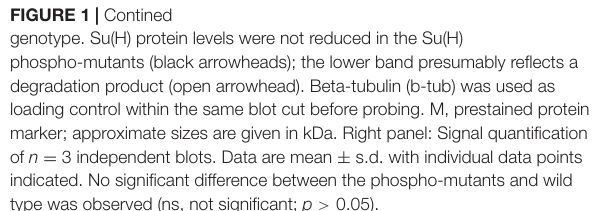
FIGURE 1 | Contined genotype. Su(H) protein levels were not reduced in the Su(H) phospho-mutants (black arrowheads); the lower band presumably reflects a degradation product (open arrowhead). Beta-tubulin (b-tub) was used as loading control within the same blot cut before probing. M, prestained protein marker; approximate sizes are given in kDa. Right panel: Signal quantification of n = 3 independent blots. Data are mean ± s.d. with individual data points indicated. No significant difference between the phospho-mutants and wild type was observed (ns, not significant; p >